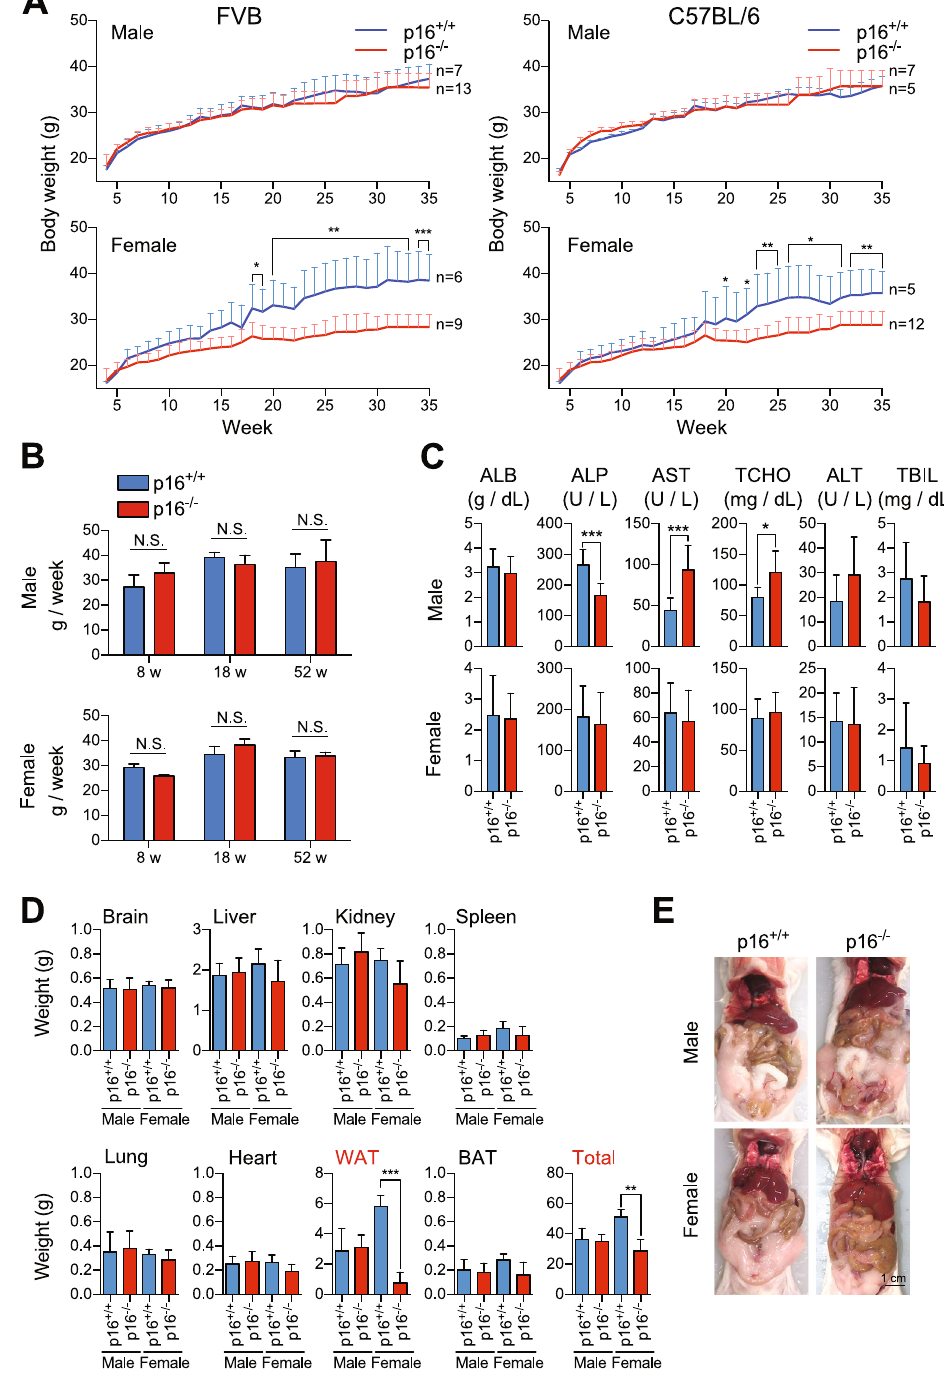
Figure 1. p16 Ink4a deficiency inhibits weight gain in female mice of different genetic backgrounds. ( A , B ) p16 + / + and p16 − / − male and female mice were weighed weekly at 4 to 35 weeks while housed specific pathogen-free on diets of 25% protein, 13% fat, and 62% carbohydrates ( A) . Food intake per mouse was measured at 8, 18, and 52 weeks ( B) (n = 5). ( C) Blood chemistry analysis of sera from 1 year old p16 + / + and p16 − / − male and female mice (n = 9). ( D , E ) p16 + / + and p16 − / − male and female mice were sacrificed at 1 year, and the brain, liver, kidney, spleen, lung, heart, white adipose tissue, brown adipose tissue, and total body were weighed D (n = 5–9). Mice were also imaged after opening the abdominal cavity ( E , A , B , D) data are representative of three independent experiments. Results are mean ±